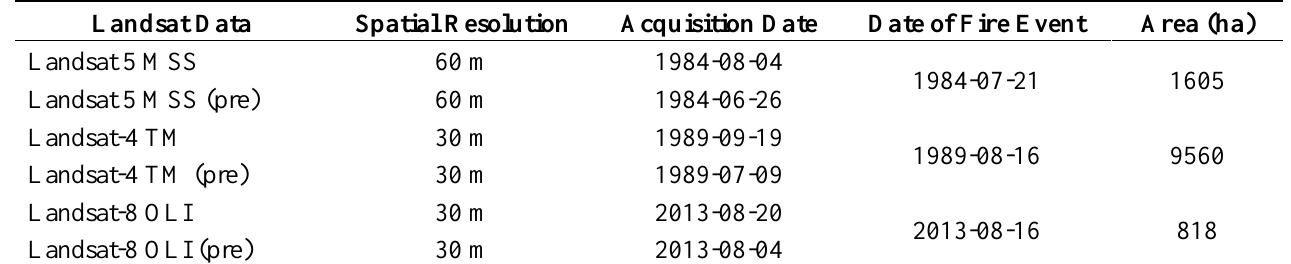
Table 1. Description of Landsat imagery used in this